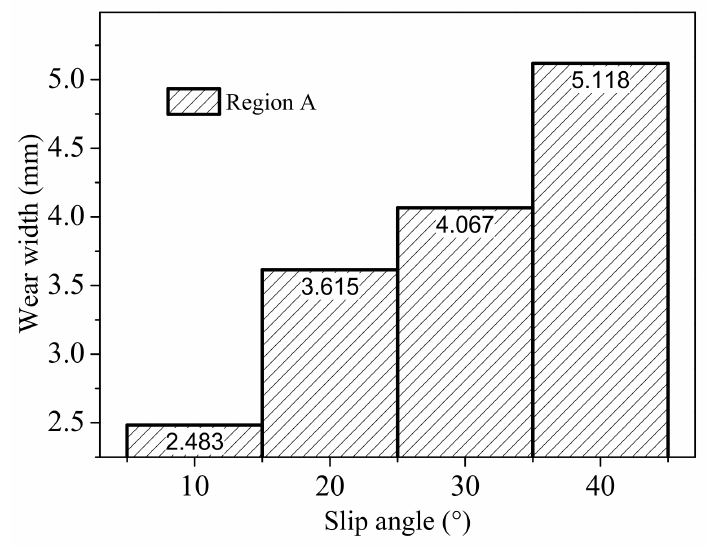
Figure 14. The variation of wear width with slip angle and wear region.